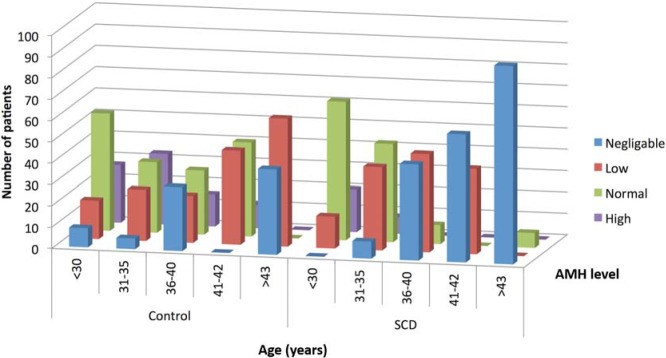
Distribution of different AMH categories in different age groups in patients with and without SCD.